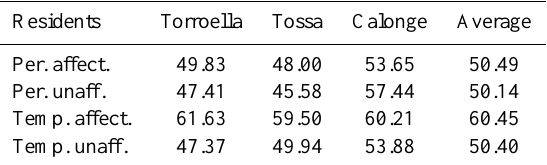
Table 6. Average age. Residents.